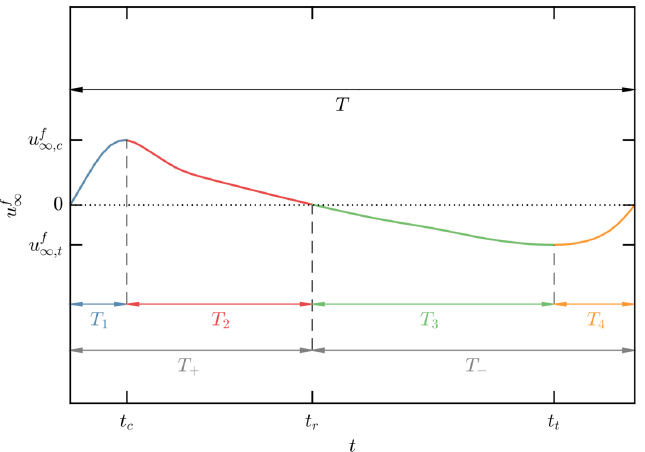
where X Q = | u f ∞ , c | / ( k s ω ) , in which u f ∞ , c is the maximum free stream velocity at the wave crest (i.e., u f ∞ , c = u f ∞ ( t c / T ) ; see Figure 10), ω = 2 π / T is the wave angular frequency, and k s , Q is the equivalent Nikuradse sand roughness. In this study, k s , Q was adjusted to match the peak of parameterized τ b , Q at the wave crest with the directly modeled τ b , max for each wave condition (see Table 3).